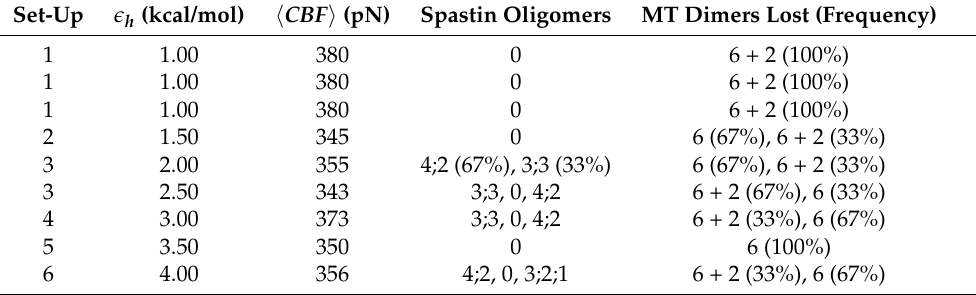
Table 2. Outcomes of simulations for the full spastin machine mounted on a MT lattice, with variable interaction strengths between the MIT domains in spastin and the MT surface.